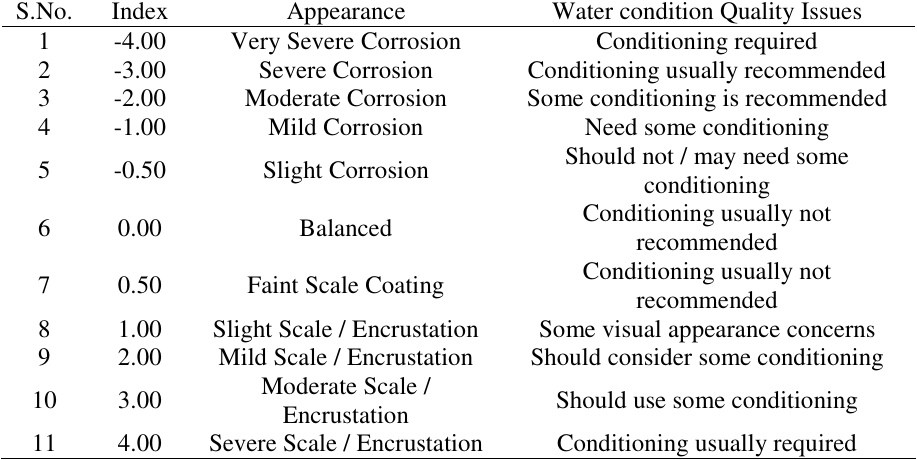
Table 4. Interpretation of lengelier saturation index (LSI) test results